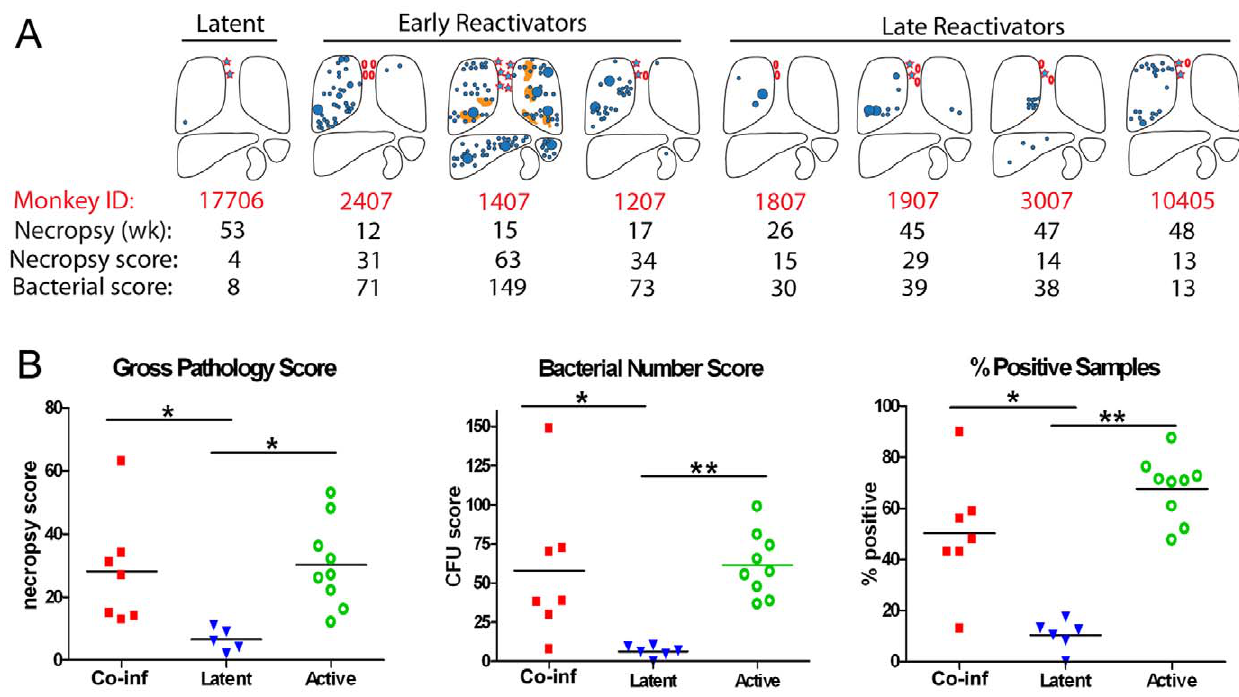
Figure 4. Pathology associated with reactivation in co-infected monkeys. A. Gross pathology at time of necropsy in co-infected monkeys. Weeks indicates time post-SIV infection for co-infected monkeys or post-Mtb infection for monkey 17706. Necropsy score represents the gross pathology score, CFU score indicates the bacterial number score. Lungs, thoracic lymph nodes, spleen, liver and kidney are represented. Granulomas are represented by blue circles, TB pneumonia by orange patches, enlarged thoracic lymph nodes by open ovals, and granulomatous thoracic lymph nodes by stars. Monkey 17706 is representative of pathology found in latent monkeys. B. Reactivation was quantified by gross pathology score, bacterial number score and percentage of tissue samples positive for Mtb in homogenized tissue. Co-infected monkeys are statistically different than latent monkeys (Mann-Whitney, gross pathology P=0.0025, bacterial number score P=0.004, % positive samples P=0.005). Latent monkeys are also statistically different than active monkeys in gross pathology (Mann-Whitney, P=0.001, bacterial number score P=0.0004, and % positive P=0.0004).